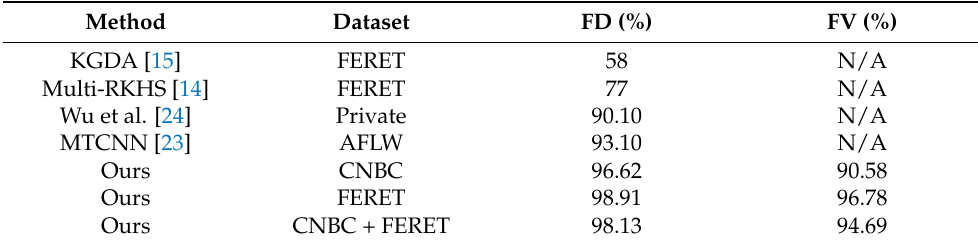
Table 1. Comparison of our method and other methods with multi-view.